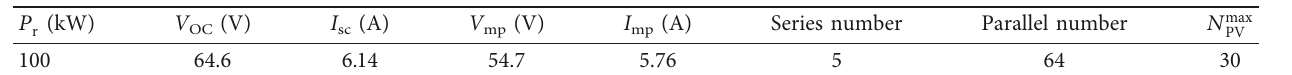
Table 4: PV panel parameters.